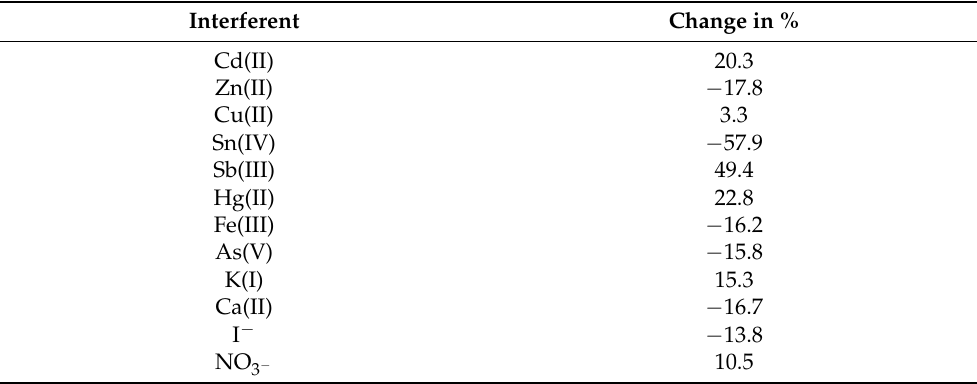
Table 1. The influence of different ions on the Pb(II) stripping signal at Pb(II):interferent mass concentration ratio of